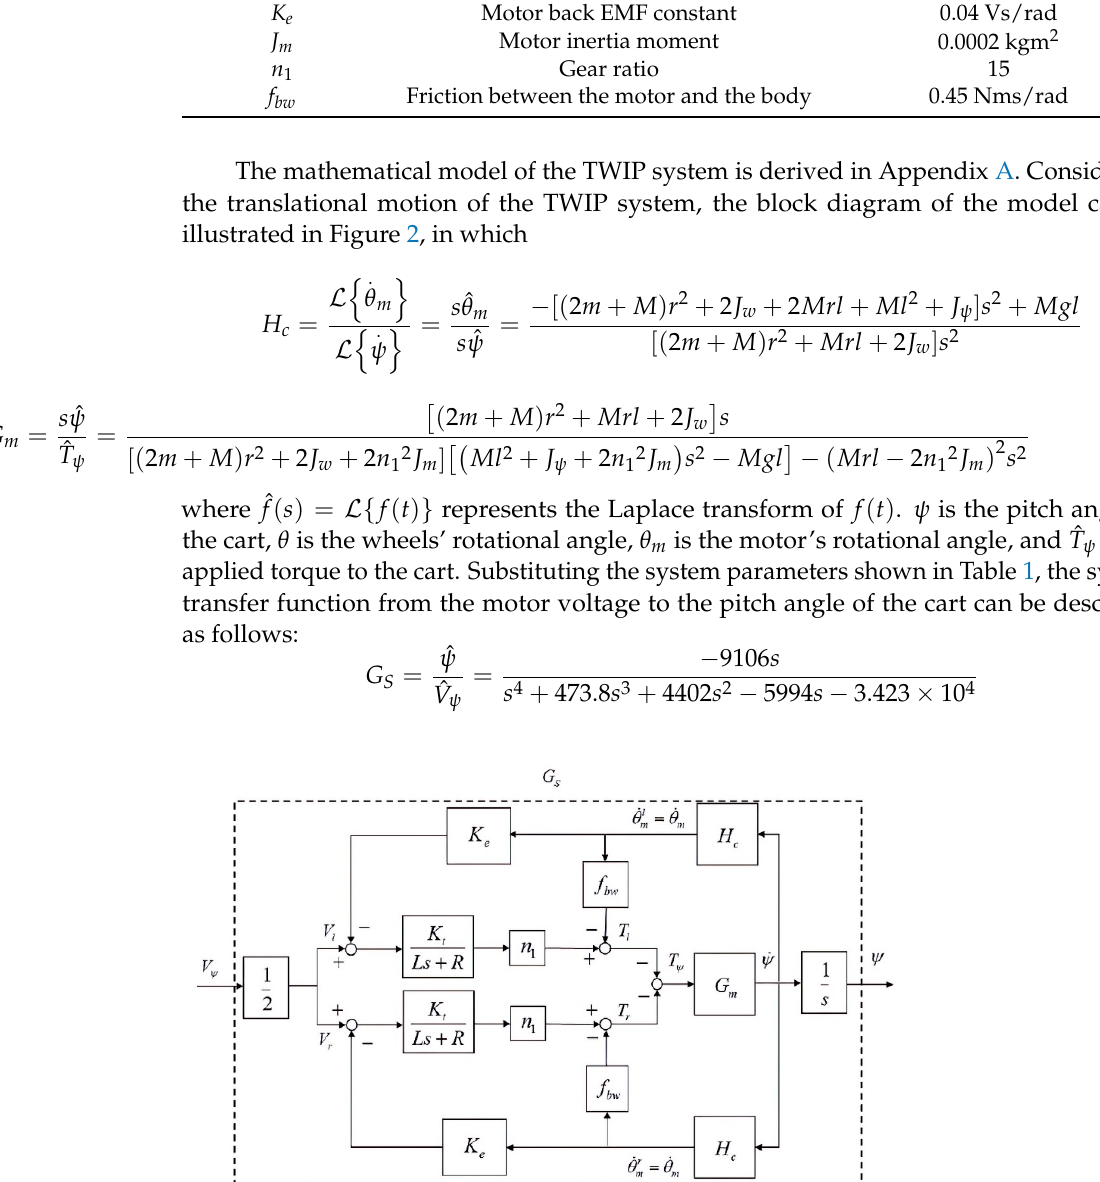
Table 1. Specifications of the TWIP system.